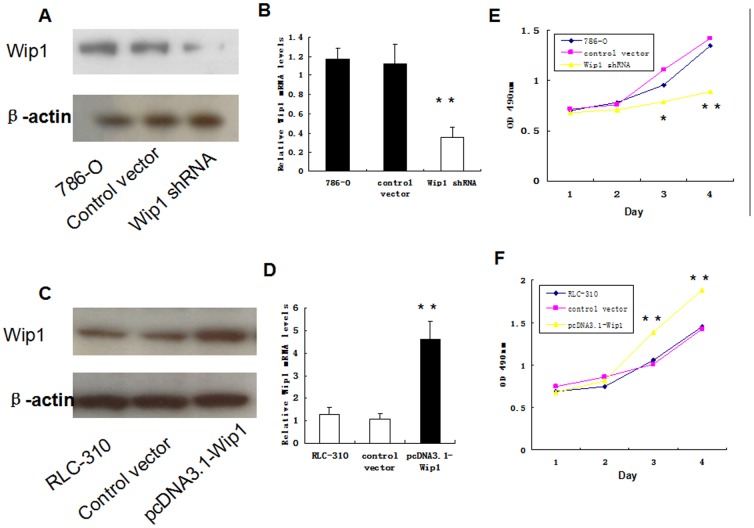
Effects of suppression and overexpression of Wip1 on RCC cell line 786-O and RLC310.The 786-O cells were transfected with control-shRNA or Wip1-shRNA, while RLC-310 cells were treated with pcDNA3.1 control vector or pcDNA3.1-Wip1, and nontransfected 786-O and RLC-310 cells were used as blank controls respectively. As compared to control groups, both mRNA and protein levels of Wip1were significantly decreased in 786-O cells after Wip1 knockdown (A, B), and remarkably increased in RLC-310 cells with Wip1 overexpression (C, D). Evaluation of cell proliferation by CCK-8 assays showed that down-regulation of Wip1 dramatically inhibited the cell proliferation rate of 786-O cells (E), whereas overexpression of Wip1 significantly promoted the growth of RLC-310 cells (F). Data were shown as mean ± SD (n = 3). **P<0.001, *P<0.05.